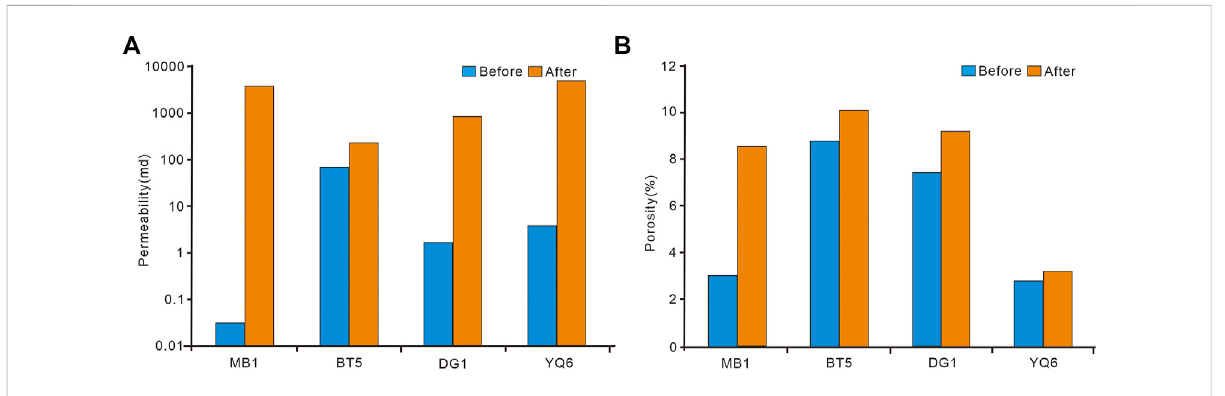
FIGURE 4 Histogram of carbonate porosity and permeability before and after dissolution (A) comparison of permeability before and after dissolution; (B) comparison of porosity before and after